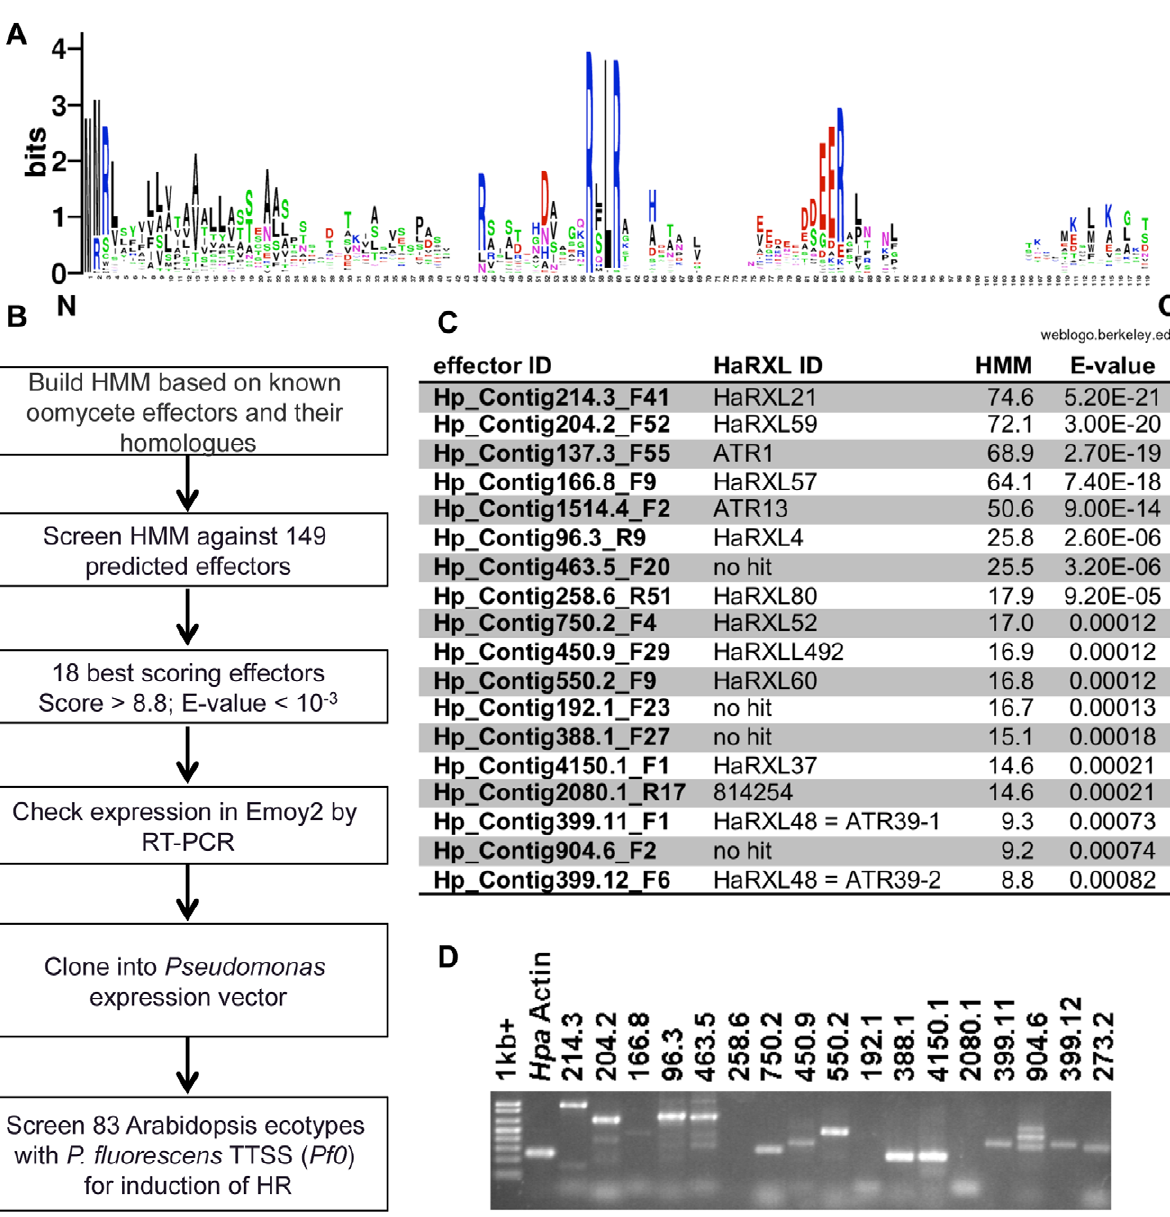
We PCR amplified the highest scoring expressed effectors from the Emoy2 isolate of Hpa , past the predicted signal peptide cleavage site, and cloned them into two Pseudomonas expression vectors. First, the effectors were shuttled into a Gateway- compatible Pseudomonas vector as C-terminal fusions with the AvrRpm1 type three secretion system (TTSS) signal peptide